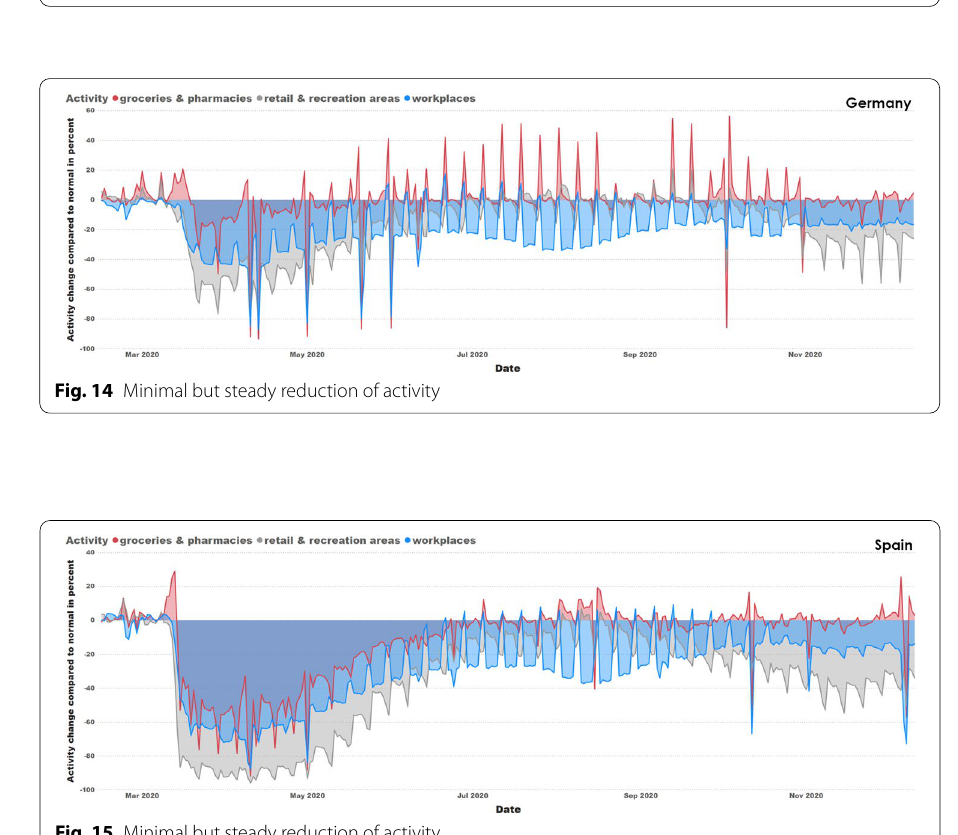
Fig. 13 Main lockdown followed by selective workplaces reduction